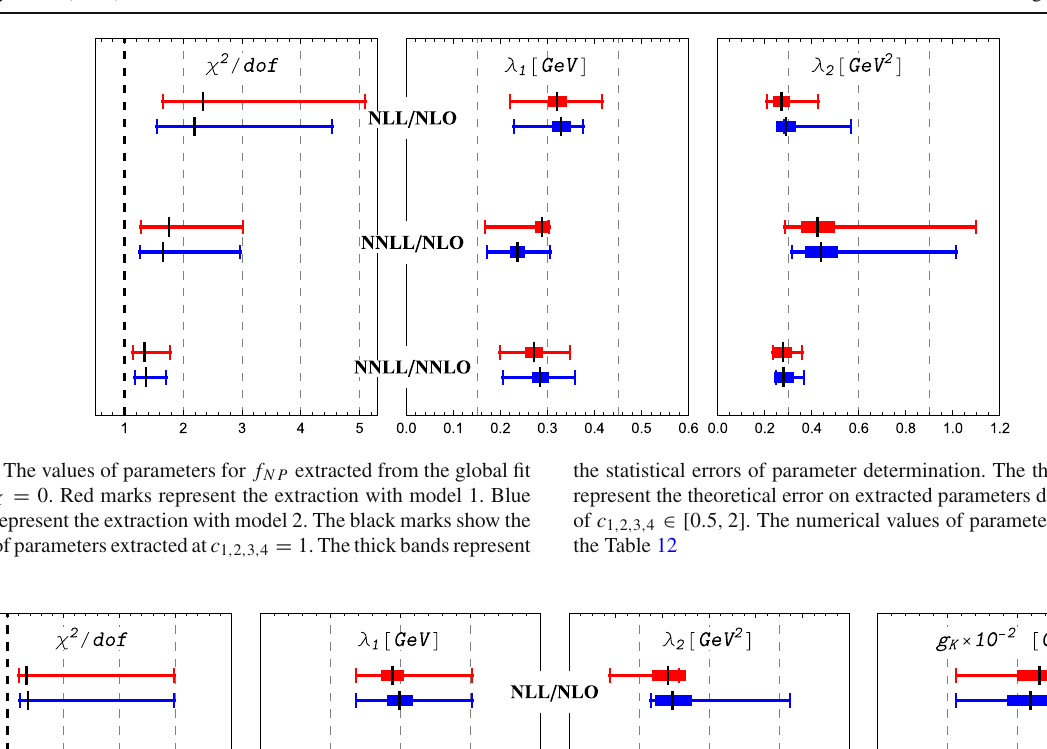
the statistical errors of parameter determination. The thin error-bands represent the theoretical error on extracted parameters due to variation of c 1 , 2 , 3 , 4 ∈ [ 0 . 5 , 2 ] . The numerical values of parameters are given in the Table